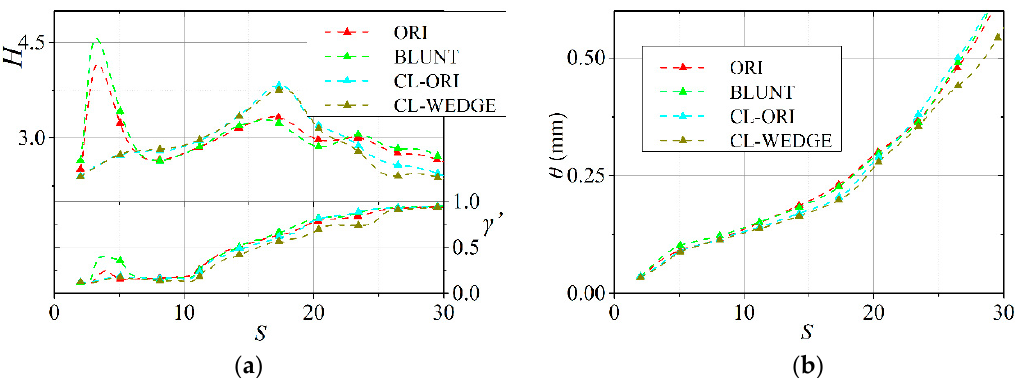
Figure 22. The different leading edge boundary layer developments at a 0.05 blade height at Tu = 2.5%, Re t = 2500: ( a ) the boundary layer shape factor and normal average turbulence intermittency; ( b ) the momentum thickness along aerofoils.